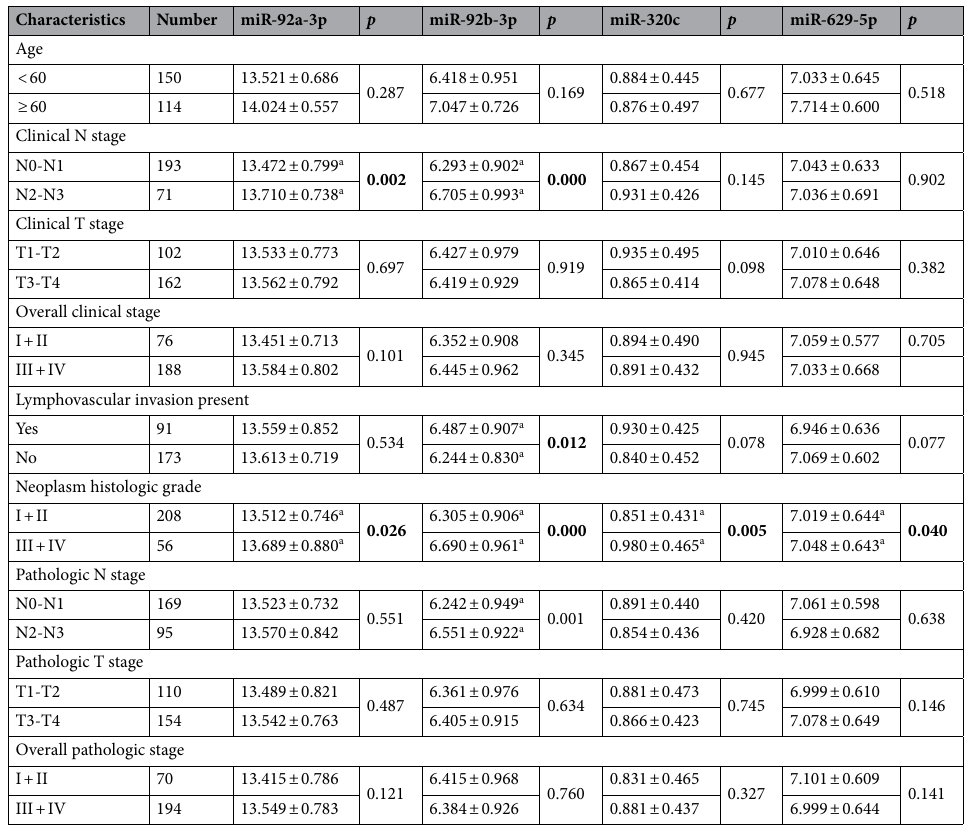
Table 1. Correlations between clinicopathological characteristics and expression levels of miRNA in the TCGA dataset. Significant values are denoted by bold font. TCGA The Cancer Genome Atlas, T tumor size, N lymph nodes, p p value. p < 0.05, p values calculated by the independent t -test.